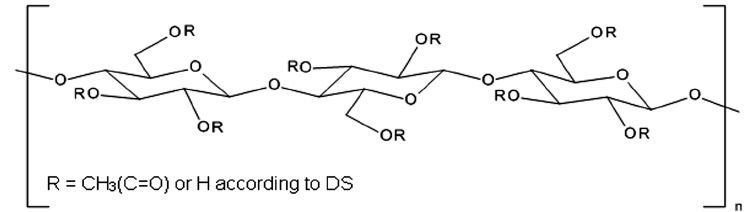
Figure 1. General structure of cellulose acetate (CA).